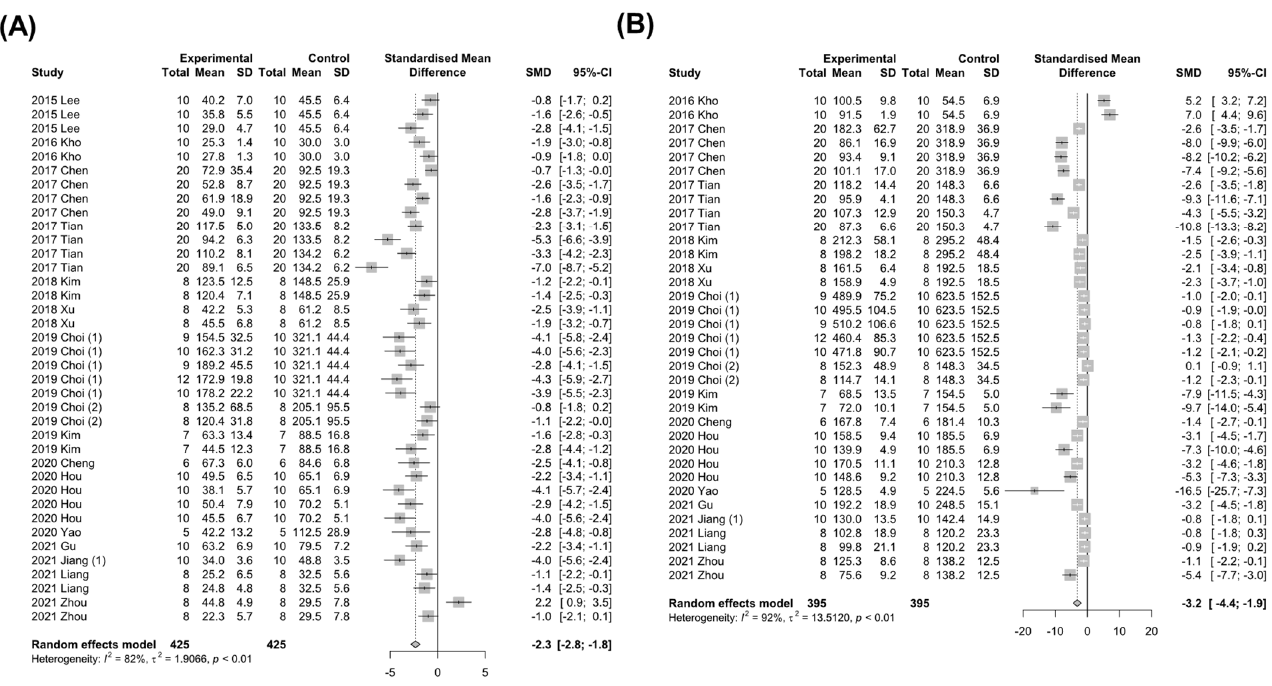
Figure 5. Effects of Panax ginseng on liver injury markers in the subgroup analysis of HFD-induced NAFLD. Forest plots for comparison: ( A ) ALT levels [7,26–28,30,32,35–37,39–41,47–49,52]. ( B ) AST levels [7,27,28,30,32,35–37,39–41,47–49,52]. SD, standard deviation.